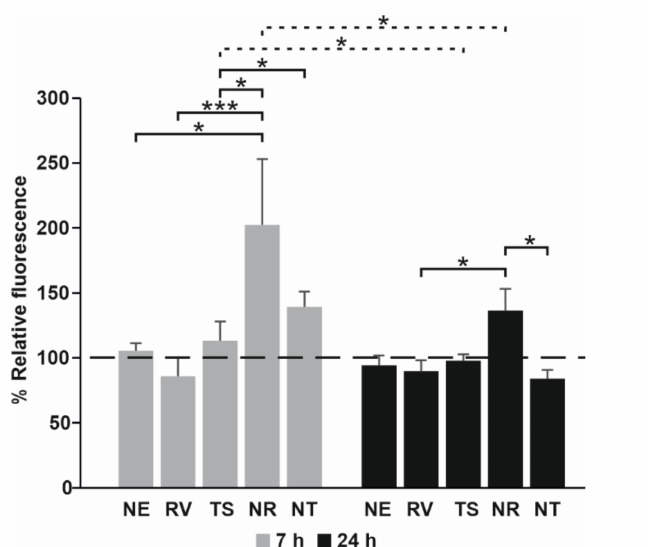
Figure 8. Color coded bar plots showing the oxidative stress of T24 cells exposed to RV and TS alone or loaded in NEs. Values were reported as mean ± SD. The presence of statistically significant differences among conditions (continuous line) and for each condition, between consecutive time points (dotted line), was also reported. * p < 0.05, *** p <